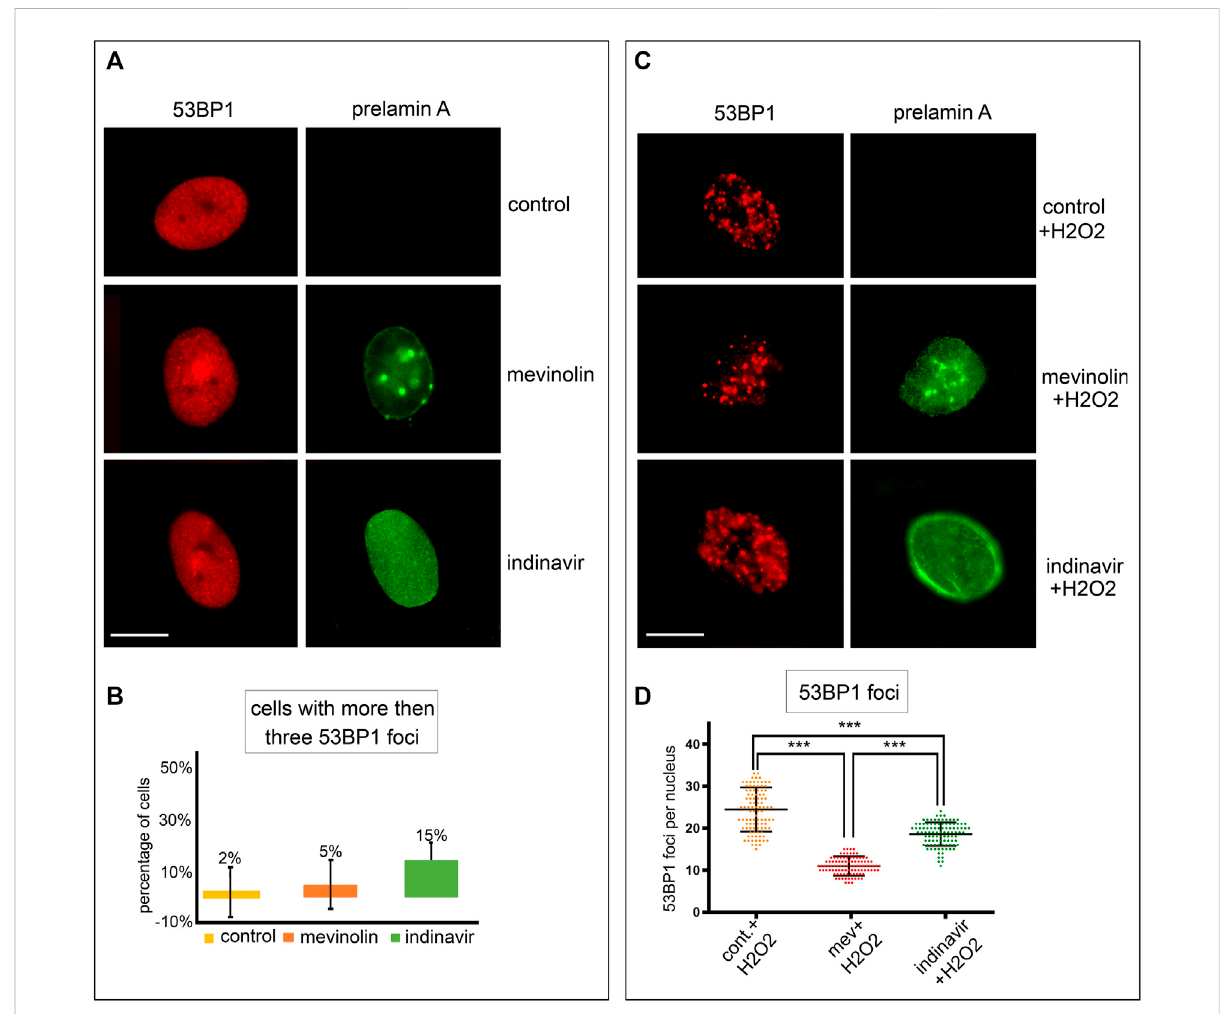
FIGURE 1 Stress-induced 53BP1 foci in human dermal fi broblasts accumulating prelamin A forms. (A) Immuno fl uorescence staining of 53BP1 and prelaminAinuntreated,mevinolin-andindinavir-treatedcells.53BP1(red),prelaminA(green).Bar,10 μ m. (B) Quantitativeanalysisofthenumberof fi broblasts showing more than three 53BP1 fociper nucleus. Experiments wereconducted intriplicate and 200 cells per sample werecounted. Data reported in the graphs are mean values +/ - standard deviation. (C) Immuno fl uorescence staining of 53BP1 and prelamin A in untreated or mevinolintreated fi broblastsuponoxidativestressinduction.53BP1(red),prelaminA(green).Bar,10 μ m. (D) Dotplotofthenumberof53BP1fociper nucleusinhumandermal fi broblastssubjectedtooxidativestress.Experimentswereconductedintriplicate,dataanalyzedwerebasedonanaverage of 100 cells. Error bars, mean ± SD. Comparison between the groups was determined by using the one-way ANOVA test. Asterisks show statistical signi fi cance (***, p <